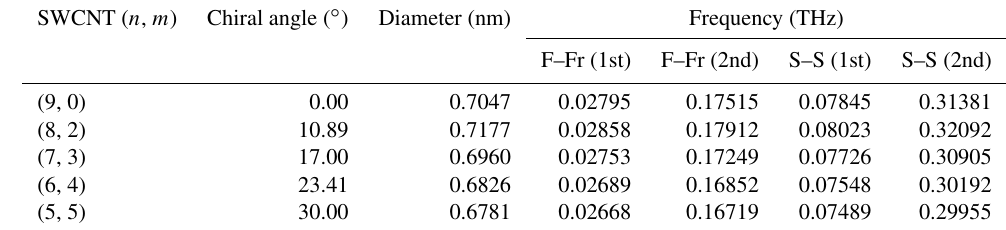
Table 2. Eigenfrequencies of carbon nanotubes with different chiral angles and boundary conditions.